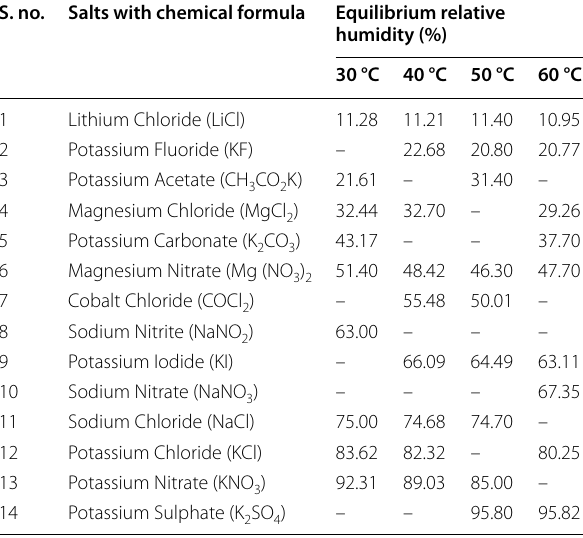
Table 1 Salts and its equilibrium relative humidity at different